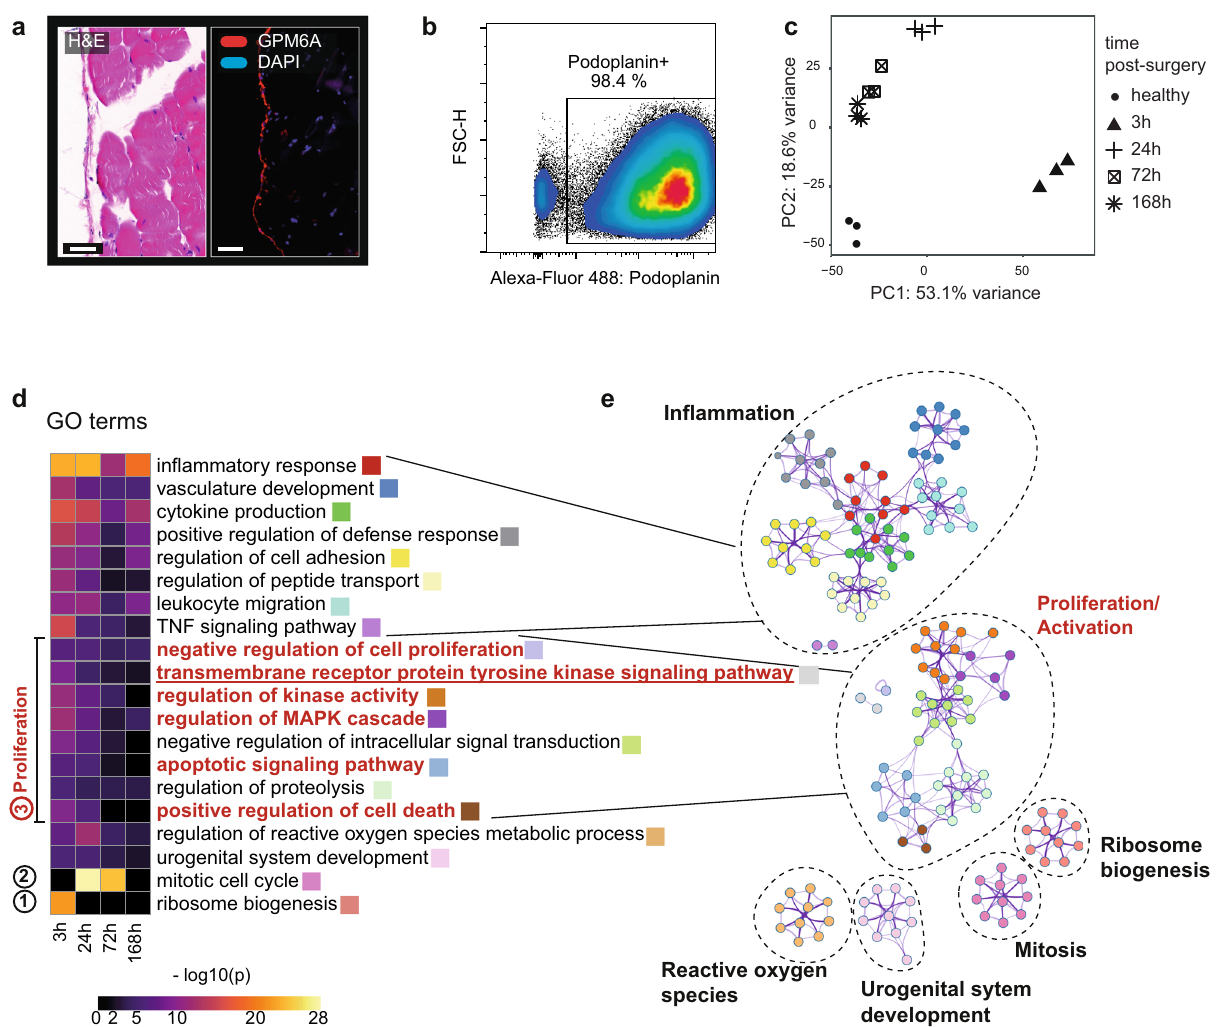
Fig. 3 Mesothelial cells undergo a profound transcriptional change post-surgery. a Cryosection of healthy abdominal wall. The mesothelium was stained by anti-glycoprotein M6A (GPM6A) antibody (right). Hematoxylin and eosin (H&E) staining (left). Scale bar: 50 µ m. Image is representative of n = 3 independent animals and two independent experiments ( b ) In vivo mesothelium digestion puri fi ed with anti-GPM6A magnetic beads purity control before undergoing RNA-Seq. c Principal components of log transformed read counts. d Differentially expressed genes (log2fold change during time-course) with signi fi cance ( p < 0.01) were loaded into Metascape to acquire gene ontology (GO) and KEGG pathway enrichment. Changes in ribosome biogenesis (Nr. 1), mitotic cell cycle (Nr. 2) and pro-proliferative/ anti-apoptotic signaling (Nr. 3) are highlighted. e GO network representation of enriched GO terms (color by cluster). N = 3 replicates (mice) sequenced per time point. Raw data were deposited at gene expression omnibus